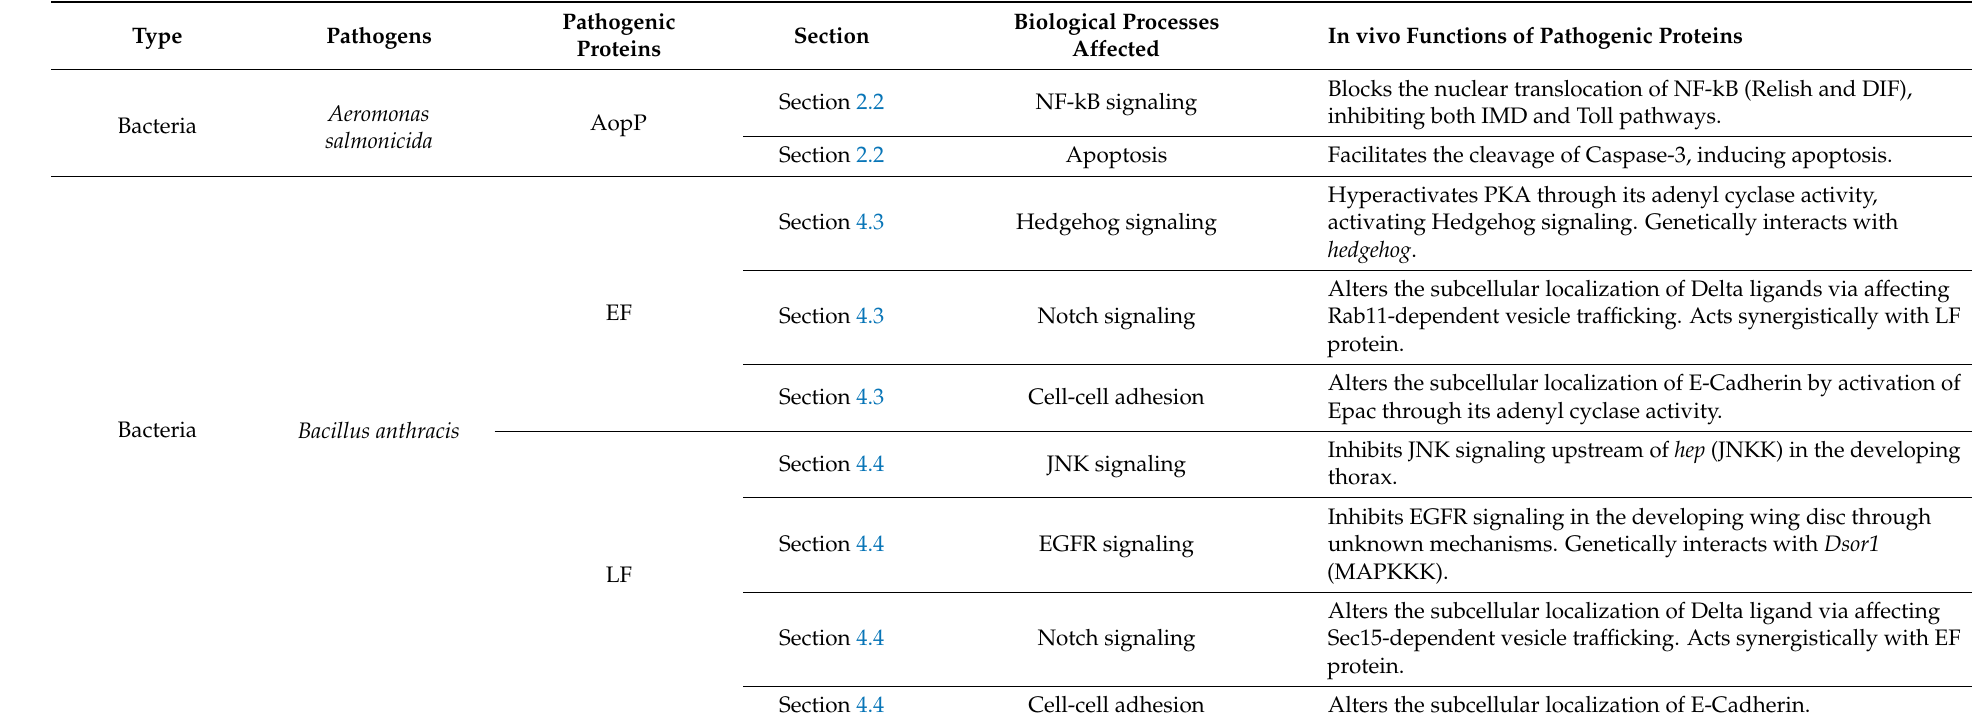
Table 1. Virulence factors studied in Drosophila and their host target